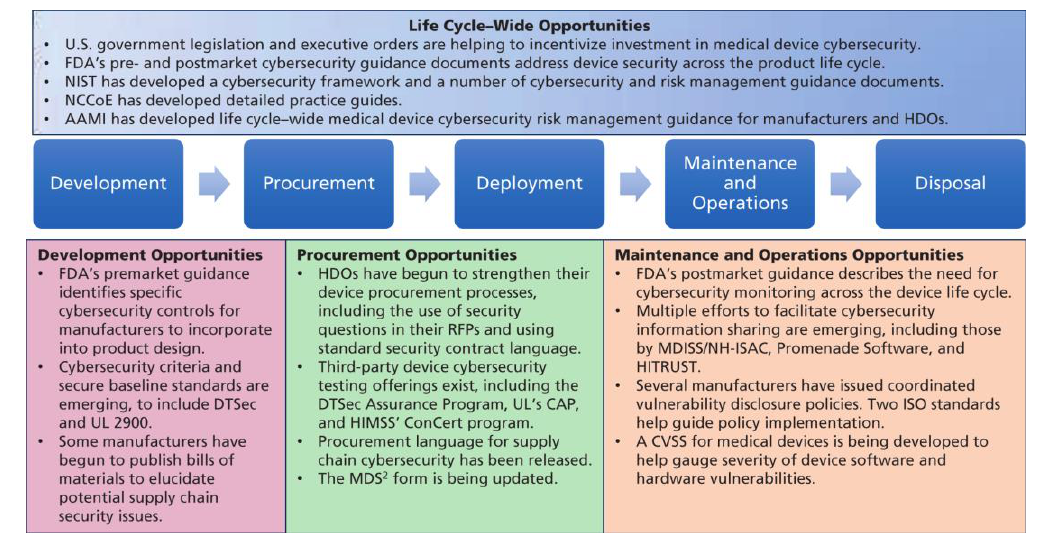
Figure 14. Summary of medical device cybersecurity life cycle opportunities. Abbreviations used: AAMI, Association for the Advancement of Medical Instrumentation; CVSS, Common Vulnerability Scoring System; DTSec, Diabetes Technology Society Cybersecurity Standard for Connected Diabetes Devices; FDA, Food and Drug Administration; HDO, Healthcare Delivery Organization; HIMSS, Healthcare Information and Management Systems Society; HITRUST, Health Information Trust Alliance; ISO, International Organization for Standardization; MDISS, Medical Device Innovation, Safety and Security Consortium; MDS2, Manufacturer Disclosure Statement for Medical Device Security; NCCoE. National Cybersecurity Center of Excellence; NH-ISAC, National Health Information Sharing and Analysis Center; NIST, National Institute of Standards and Technology; and RFP, Request for Proposal [84].